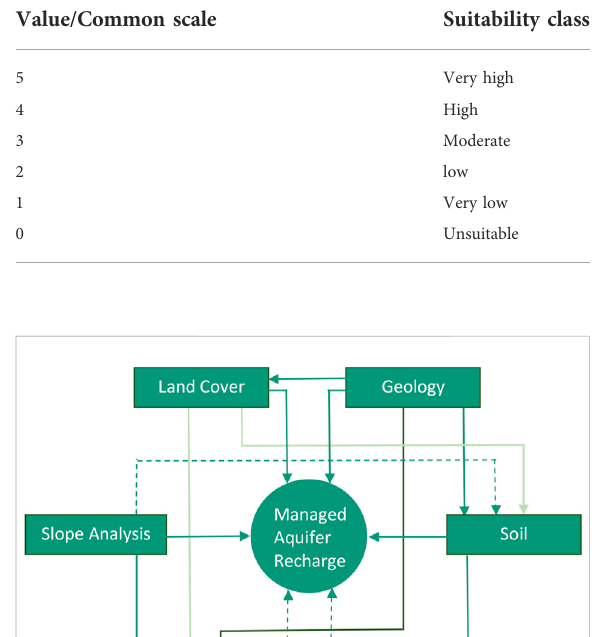
TABLE 2 Standardization of criteria and their suitability class.